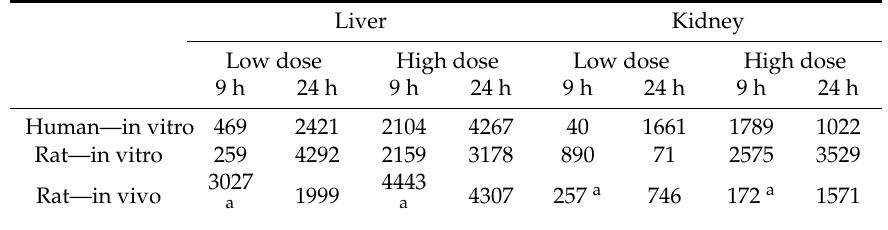
Table 3. Di ff erentially expressed genes obtained from human primary hepatocytes and renal tubular epithelial cells after exposure to thioacetamide-S-oxide. The rat in vivo and in vitro data are from [25]. Liver Kidney Low dose High dose